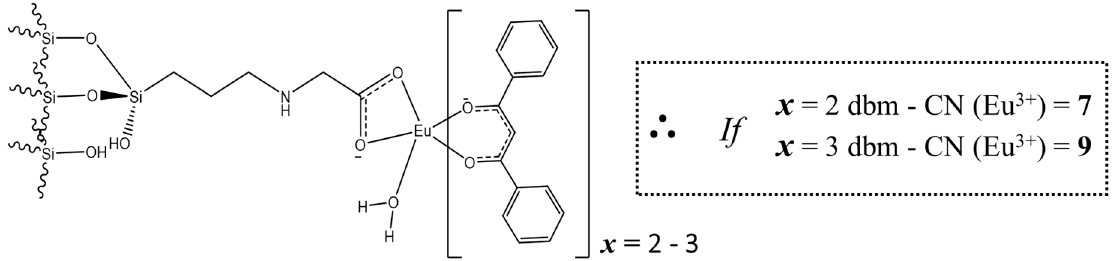
Figure 7. Eu 3 + local sites on the SiO 2 surface with coordination number (CN) seven or nine. Figure 7. Eu 3+ local sites on the SiO 2 surface with coordination number (CN) seven or nine.